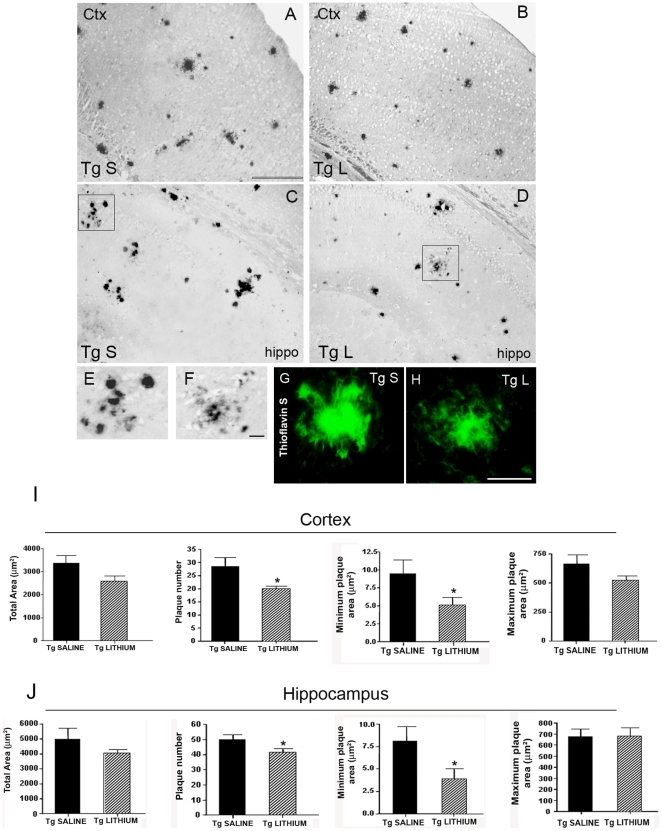
Lithium treatment reduced the de novo formation of Aβ plaques in 7-month-old TgCRND8 mouse brain.A–D: immunohistochemical detection of Aβ plaques in the cortex (A,B) and hippocampus (C,D) of saline-treated (A,C) and lithium-treated (B,D) 7-month-old TgCRND8 mice. Scale bar = 200 µm (A–D). E,F: higher magnifications of the squared areas in C and D, respectively. Note in F a radiating plaque in the lithium-treated group displaying a less dense core with fewer and smaller round-shaped deposits in its surroundings compared to the radiating plaque in E of the saline-treated group. Scale bar = 25 µm (E–F). G,H: Thioflavin S histochemistry of a radiating Aβ plaque in the saline (G)-and lithium (H)-treated Tg mice. Note in H the ribbon-like morphology of the β-amyloid plaque core and the reduction of compact deposits in the main amyloid core surroundings compared to the Aβ load in the G image. Scale bar = 25 µm (G–H). I,J: in bar graphs are reported the quantitative analyses of the total area, plaque number and minimum and maximum plaque area in the cortex and hippocampus of saline-and lithium-treated Tg mice. Only the plaque number and the minimum plaque area resulted significantly reduced by lithium treatment *P<0.05 versus Tg saline, Student's t-test.